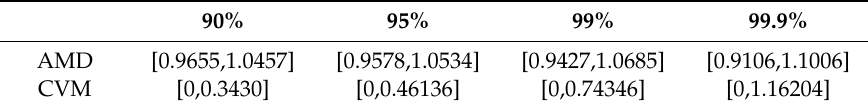
Table 3. Confidence interval for Cramer–von Mises (CVM) [12] and Mahalanobis Distance (MD) for ∞ samples.